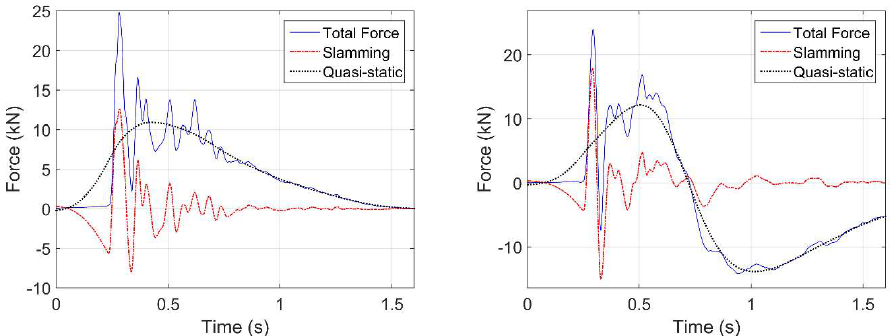
Figure 12. Total, slamming, and quasi-static force histories in the horizontal ( left ) and vertical direction ( right ), obtained via the empirical mode decomposition method, for H = 0.90 m